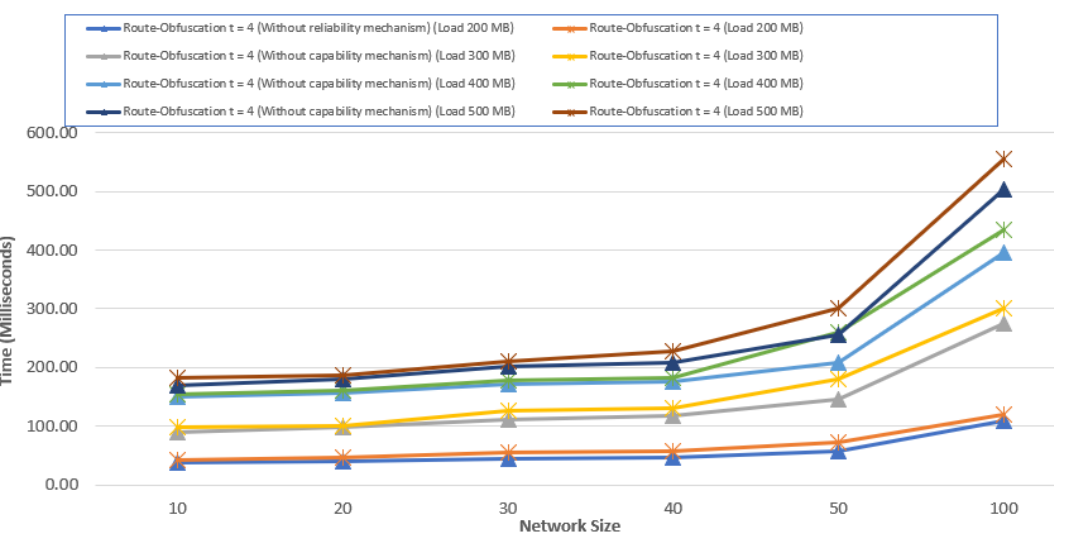
Figure 8. Average execution time comparison of using the route obfuscation algorithm for t =